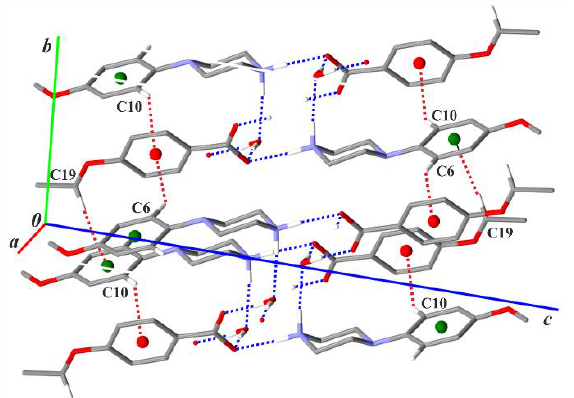
Figure 5. Part of the crystal structure of compound (I) showing a scheme of the C — H··· π (arene) intermolecular interactions (red dotted lines). Green and red balls represent the Cg 2 and Cg 3 centroids of the arene rings in the cations and anions, respectively. For the sake of clarity, the H atoms bonded to C atoms not involved in the motifs shown have been omitted.